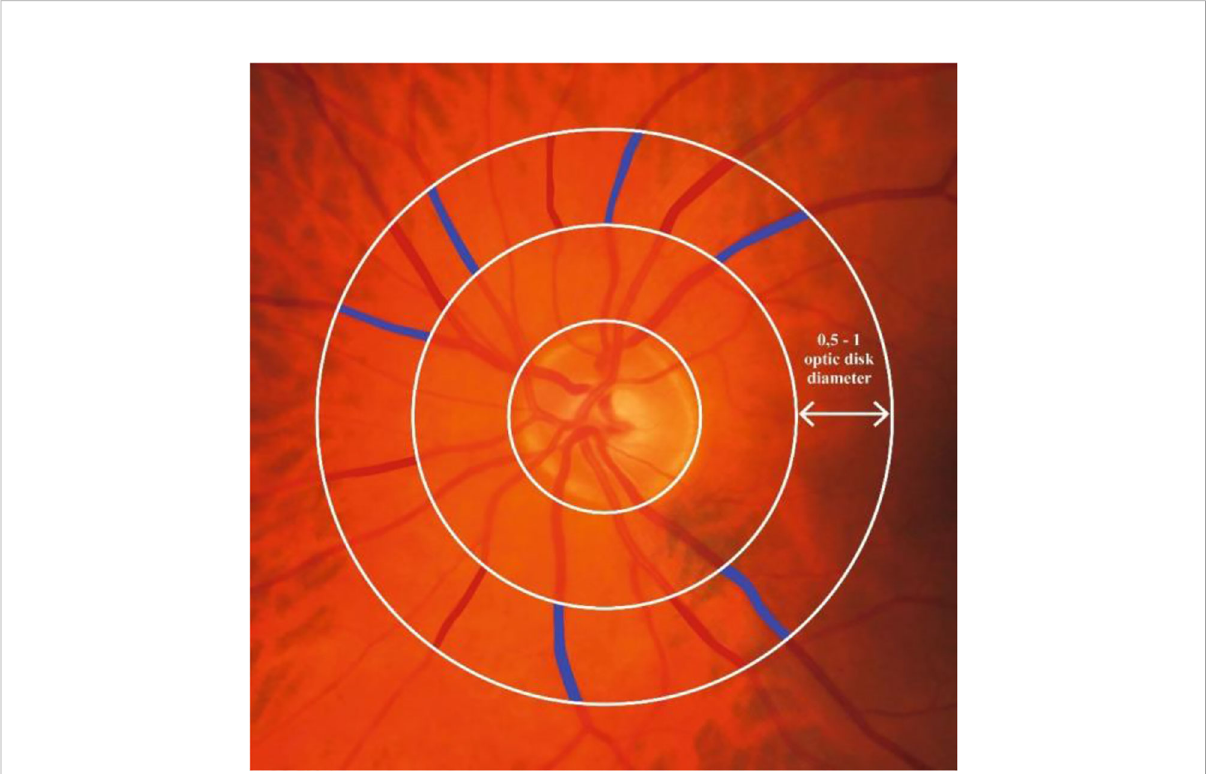
FIGURE 2.3 Retinal microvascular diameters. Figure 2.3 shows where retinal arteriolar and venular diameters can be assessed around the optic nerve. Red and blue color indicate the area on the fundus photo covered by an arteriole and venule, respectively, at 1 disk diameter from the optic nerve